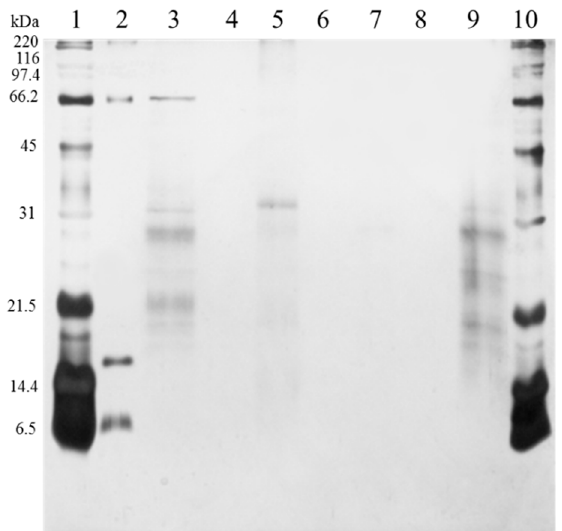
Figure 1. SDS-PAGE analysis of the functionalized core-shell silica nanoparticles (FCSNP) elutions after incubation with urine from a healthy donor for 60 min. Lanes were loaded with 1 µg of protein and arranged as follows. Broad range molecular weight standards (lanes 1 and 10); BSA, 66 kDa, myoglobin, 17 kDa, and aprotinin, 6.5 kDa (lane 2); urine, without passing through FCSNP (lane 3); sample buffer (lanes 4, 6 and 8); elution with 50% isopropanol (lane 5). Simultaneous exclusion of high molecular weight proteins and capture of low molecular weight proteins ~34 kDa and smaller was achieved in elution with 50% methanol, one faded band ~30 kDa (lane 7) and ACN+NH 4 OH (lane 9).